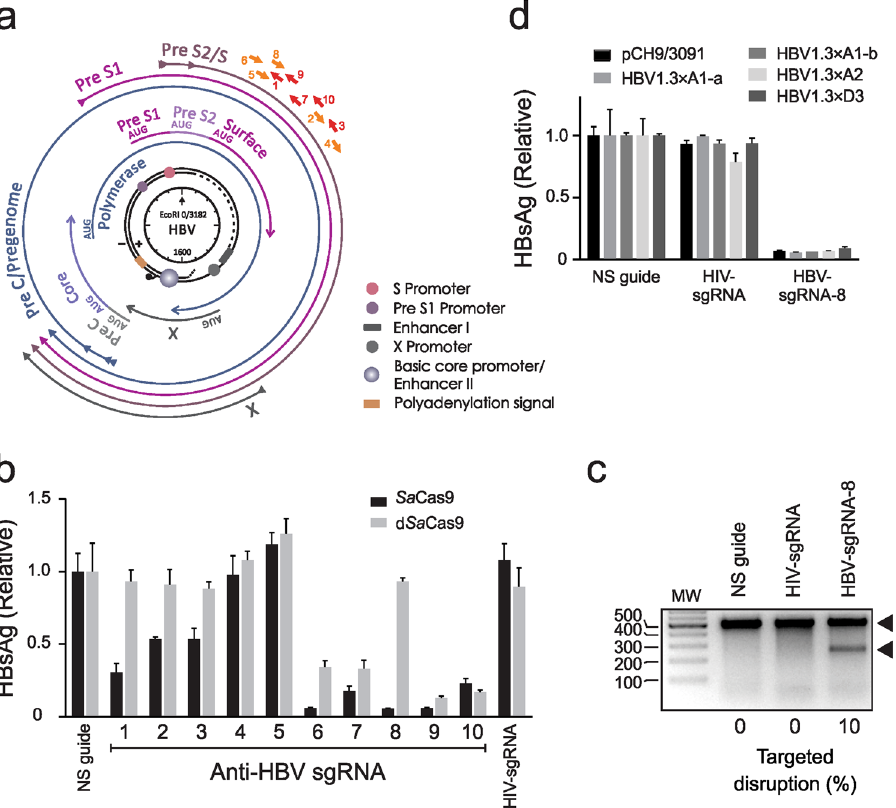
Figure 1. Screening of panel of anti-HBV SaCas9-sgRNAs. ( a ) Schematic illustration of the HBV genome with indicated open reading frames (ORFs). The viral rcDNA, with regulatory cis elements, is indicated at the center and coordinates are given relative to the single Eco RI site. The four HBV ORFs are shown as arrows immediately surrounding the genome and the four major viral transcripts are indicated as outermost arrows. The sgRNA target sites are depicted as arrows encompassing most of the sequence of the surface ( S ) region of the virus. ( b ) Huh7 cells were co-transfected with plasmids encoding i) a replication competent molecular clone of HBV (pCH-9/3091), ii) each of a panel of cassettes expressing S -targeting single guide RNAs (sgRNAs) and iii) either SaCas9 or catalytically dead SaCas9 (dSaCas9) expressed from a CMV promoter/enhancer element. The concentrations of HBV S antigen were measured using an ELISA and data are presented relative to the values for the mean for a non-specific sgRNA sequence. A sgRNA targeted to HIV (HIV-sgRNA) was included as an additional negative control. Data are represented as the means and the error bars indicate standard deviation. ( c ) HEK293T cells were transfected with SaCas9 and sgRNA-8 with pCH-9/3091. A T7E1 assay was performed on extrachromosomal cellular DNA. Arrows indicate the larger intact PCR product (~550 bp) and smaller digested fragment (~280 bp). The measured target disruption is indicated below as a percentage. ( d ) Huh7 cells were transfected with SaCas9 and sgRNA-8 targeting a greater than genome length molecular clone (1.3 × ) for HBV sub-genotypes A1, A2 and D3. Data are presented as in